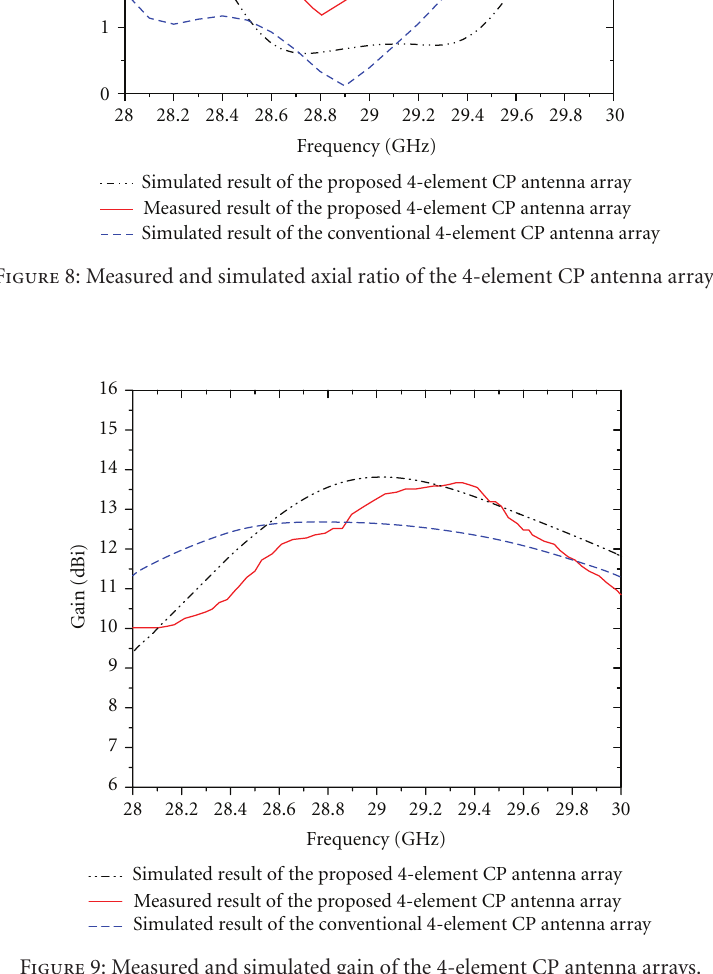
Figure 9: Measured and simulated gain of the 4-element CP antenna